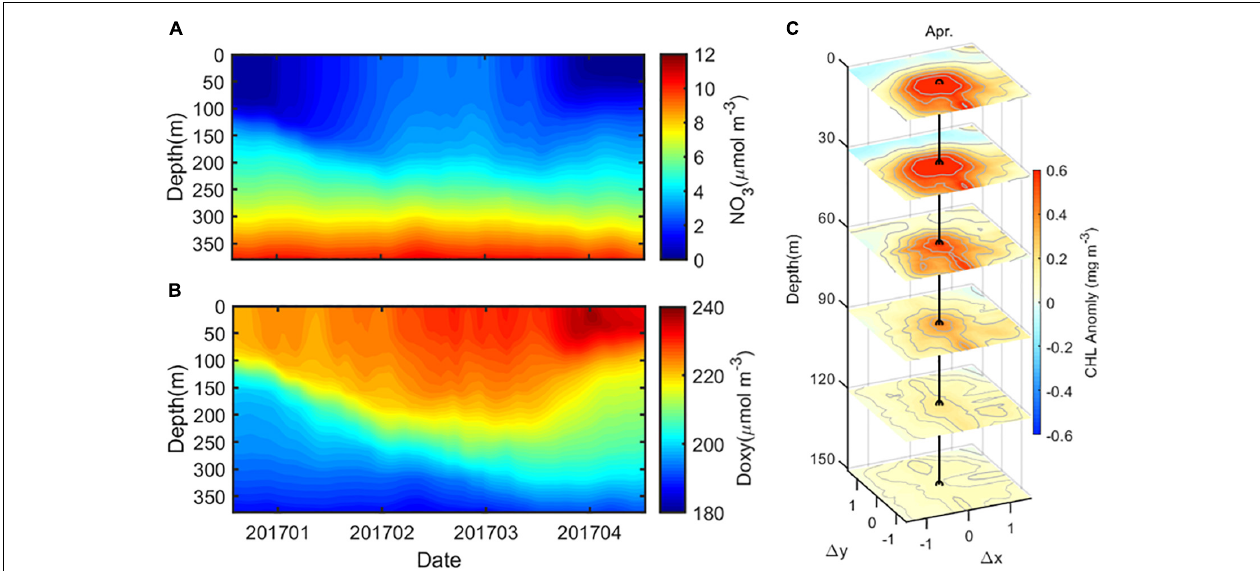
FIGURE 12 | Time series of (A) NO 3 and (B) DO averaged in 1.5 times radius of the SSAE in the winter of 2017, and (C) the composite three-dimensional CHL anomaly structure of SSAE in April